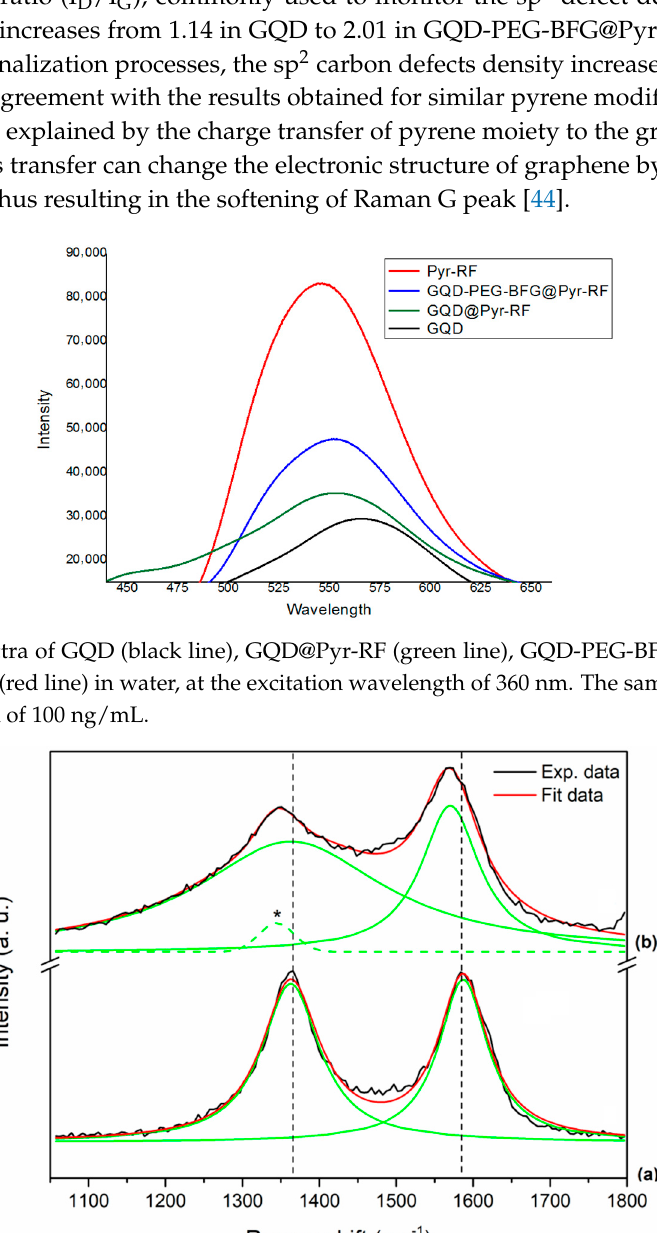
Figure 4. PL spectra of GQD (black line), GQD@Pyr-RF (green line), GQD-PEG-BFG@Pyr-RF (blue line), and Pyr-RF (red line) in water, at the excitation wavelength of 360 nm. The samples were tested at a concentration of 100 ng/mL.